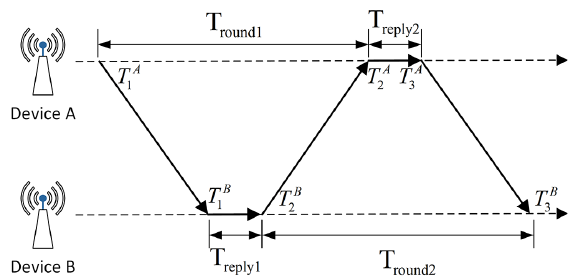
Figure 2. The data packet is sent 3 times in DSTW.